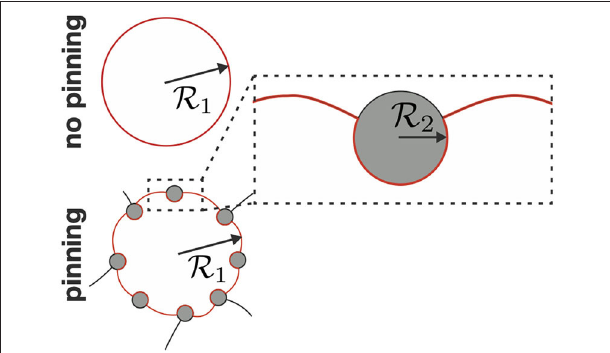
FIGURE 2 | Sketch of the impact of Zener pinnning on grain interface roughness (after Bercovici and Ricard, 2012; Mulyukova and Bercovici, 2019). Shown is a sketch of a grain surrounded by secondary particles, with a zoom on the interface around one of the secondary